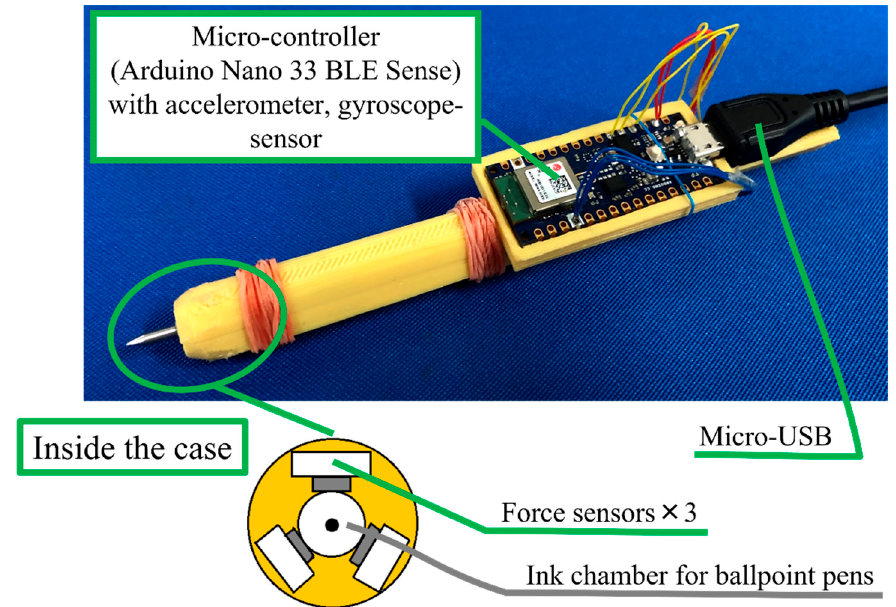
Figure 1. The developed smart pen hardware system.